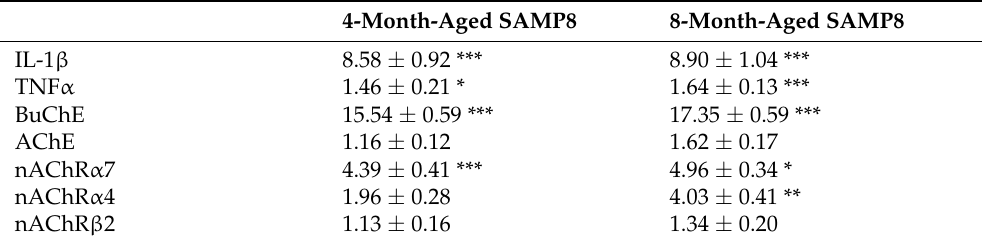
Table 6. Gene expression (2 − ∆∆ Ct ) of IL-1 β , TNF α , BuChE, AChE, nAChR α 7, nAChR α 4 and nAChR β 2 in the hippocampus of 4- and 8-month-aged SAMP8 mice in relation to the hippocampus samples from the age-matched SAMR1